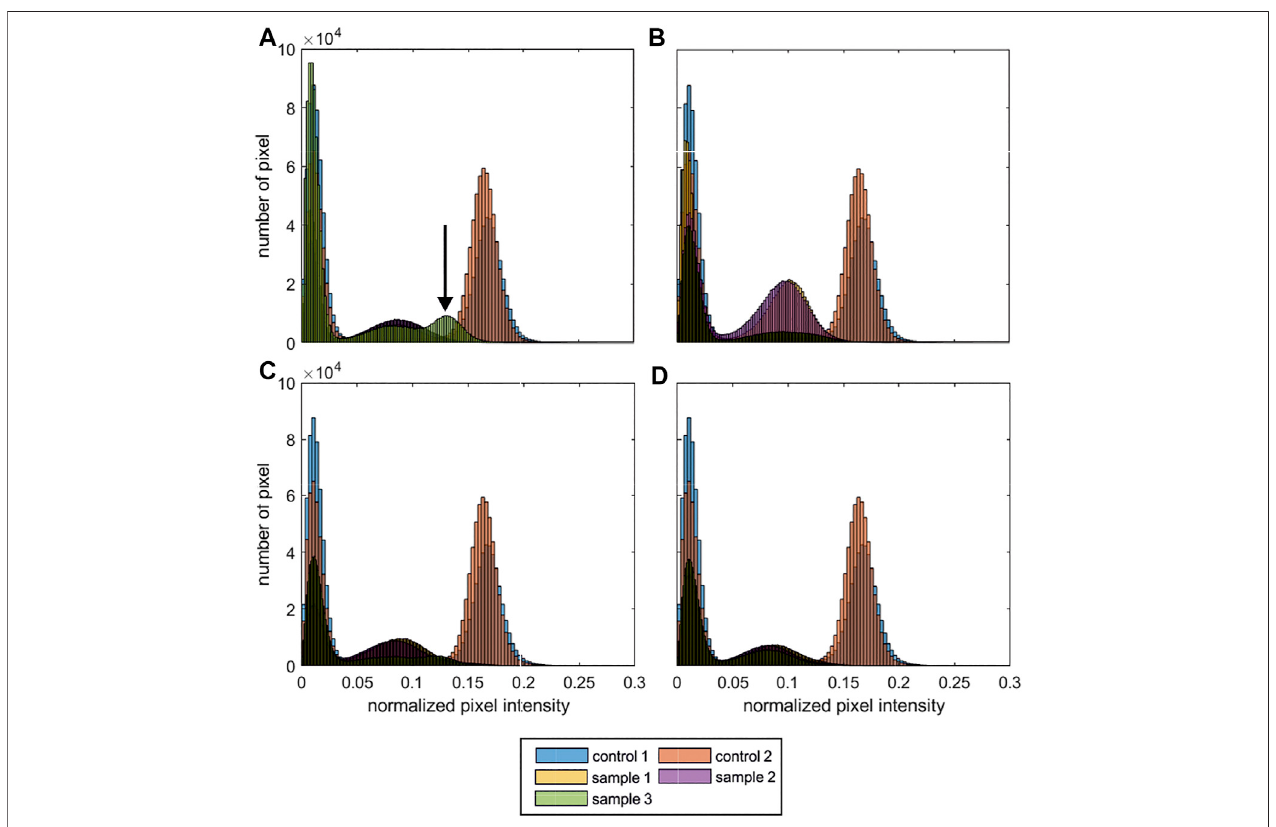
FIGURE 3 | MRI histograms of the process samples. Shown are the histograms of the normalized pixel intensity (including all 15 slices of each MRI data set). For eachrun3objectswereproducedandanalysed.Forcomparisonthecontrolsamples1+2( Figure2 )areshownineachsub- fi gure. (A) run1; (B) run2; (C) run4; (D) run 4. (n scaffolds, cell = 4 × 3 = 12 cubic scaffolds; n scaffolds, reference = 2 cubic scaffolds) The arrow indicates an anomalous normalized pixel intensity pro fi